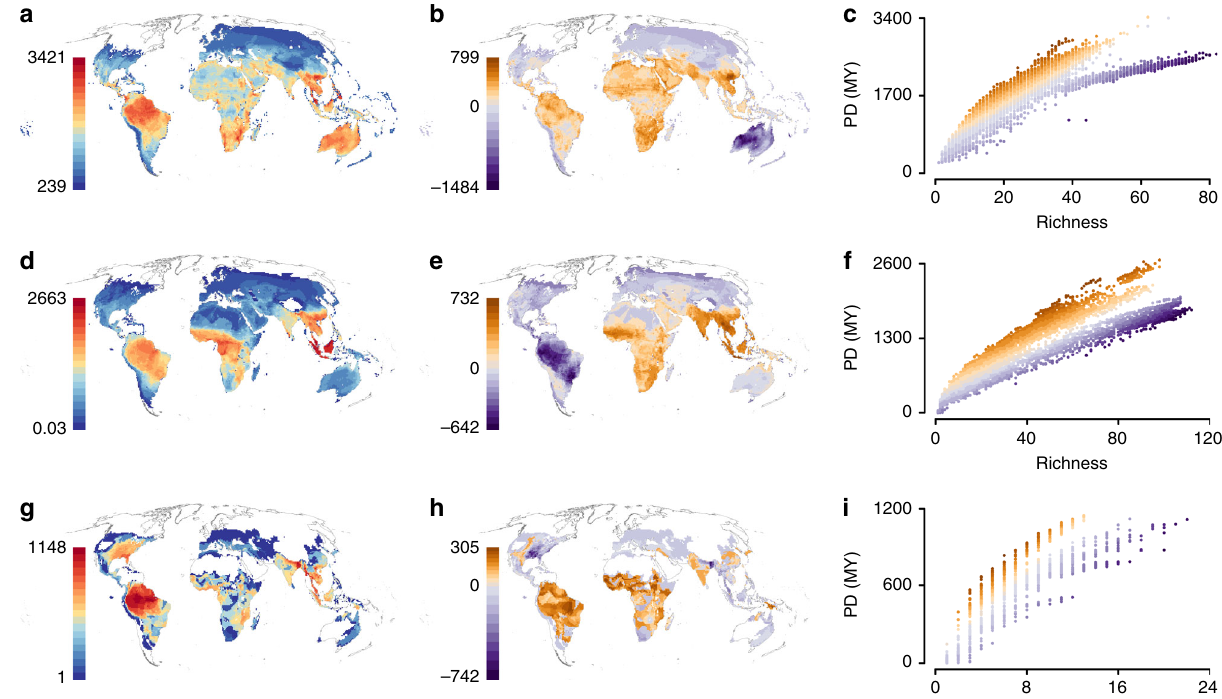
Fig. 2 Global patterns of reptilian phylogenetic diversity (PD). Cumulative PD, in millions of years (MY) (left), Middle: residual PD per grid cell, in MY, (warm colours: more than expected given richness, cold colours: less than expected given richness), Right: the relationship between richness and PD across all grid cells from the middle panels for lizards ( a – c ), snakes ( d – f ), and turtles ( g – i ), with colours corresponding to the grid cell values from the middle